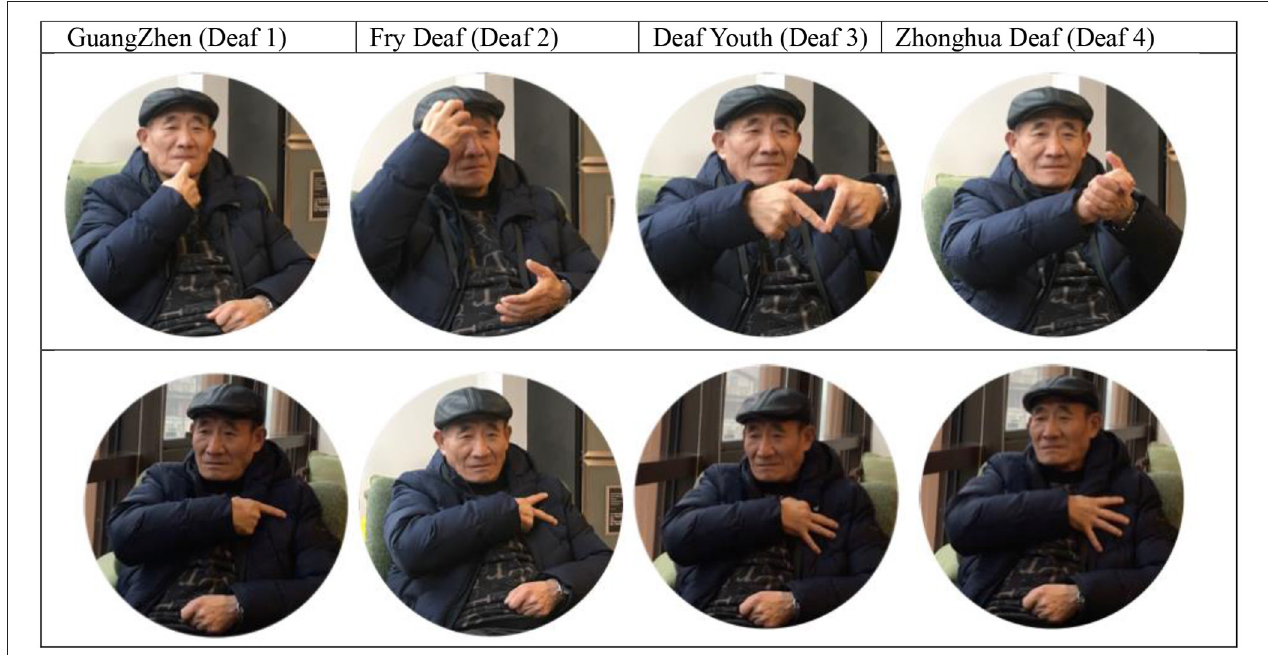
FIGURE 6 | *The sign names of major Shanghai deaf schools before and after conversion (The model is Mr. Zhuang, the first colume is old school signing names and the second colum is the names after conversion). *As shows above, contrastively, all the old sign names are symbolic of the founders or the contributors of the schools while the sign names of their respective successors show the uniformity: numbers of fingers at the left chest suggest of their numbering.